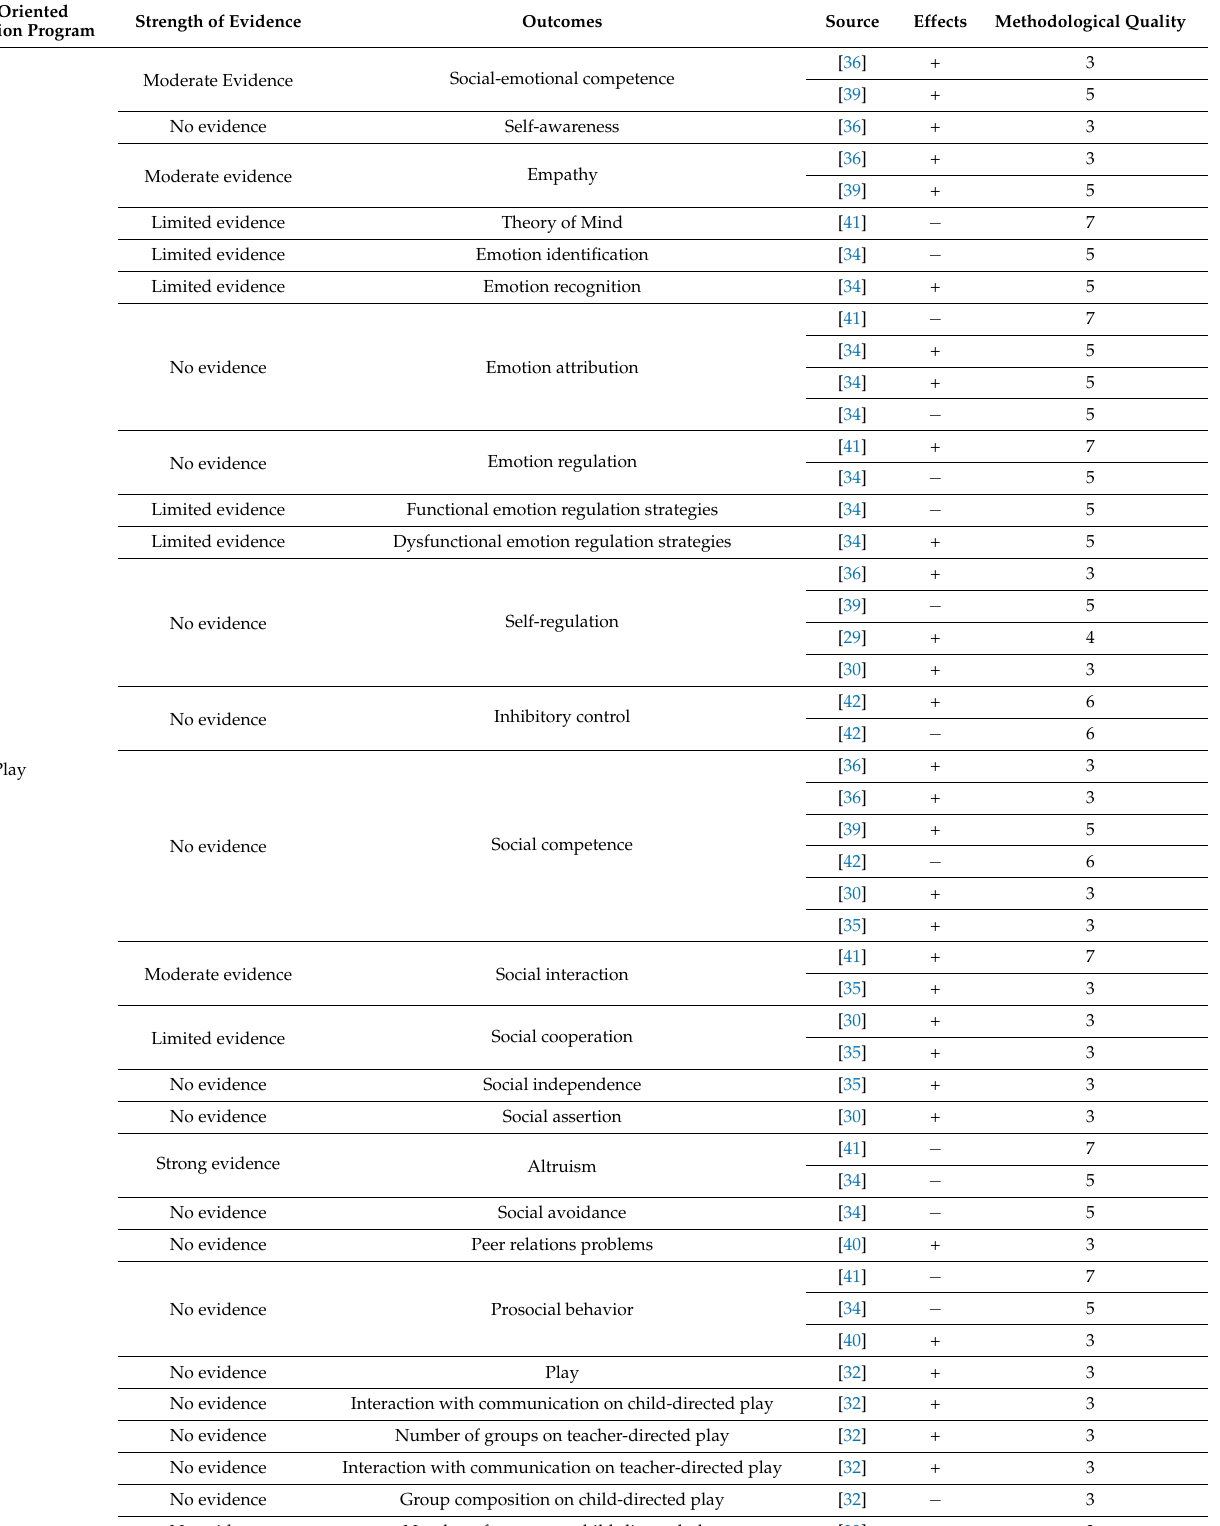
Table 2. Strength of the evidence on the effects of each body-oriented intervention program. Body-Oriented Intervention